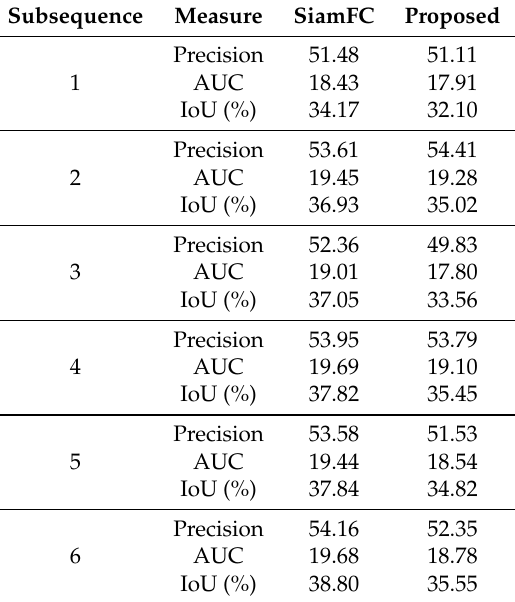
Table 2. The precision, AUC, and IoU of